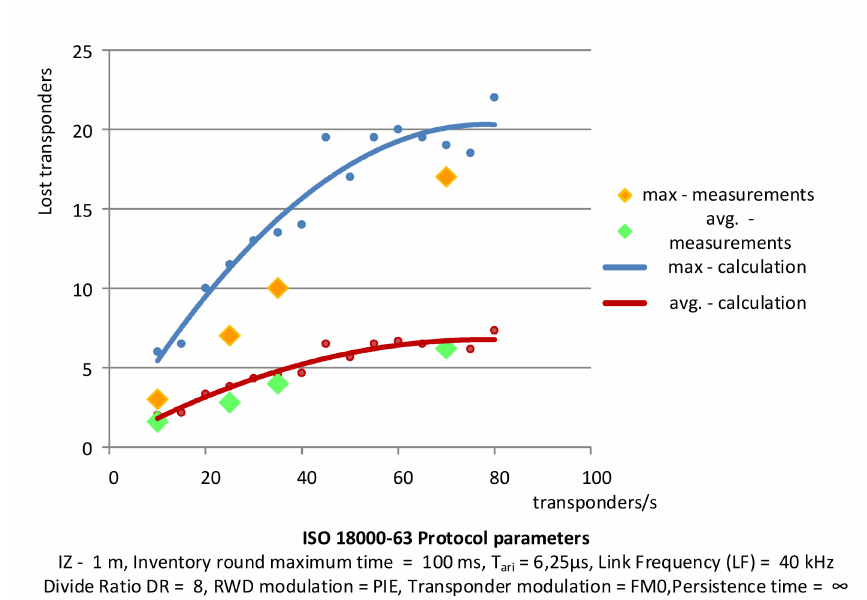
Figure 19. Comparison of experimental measurements of identification losses with